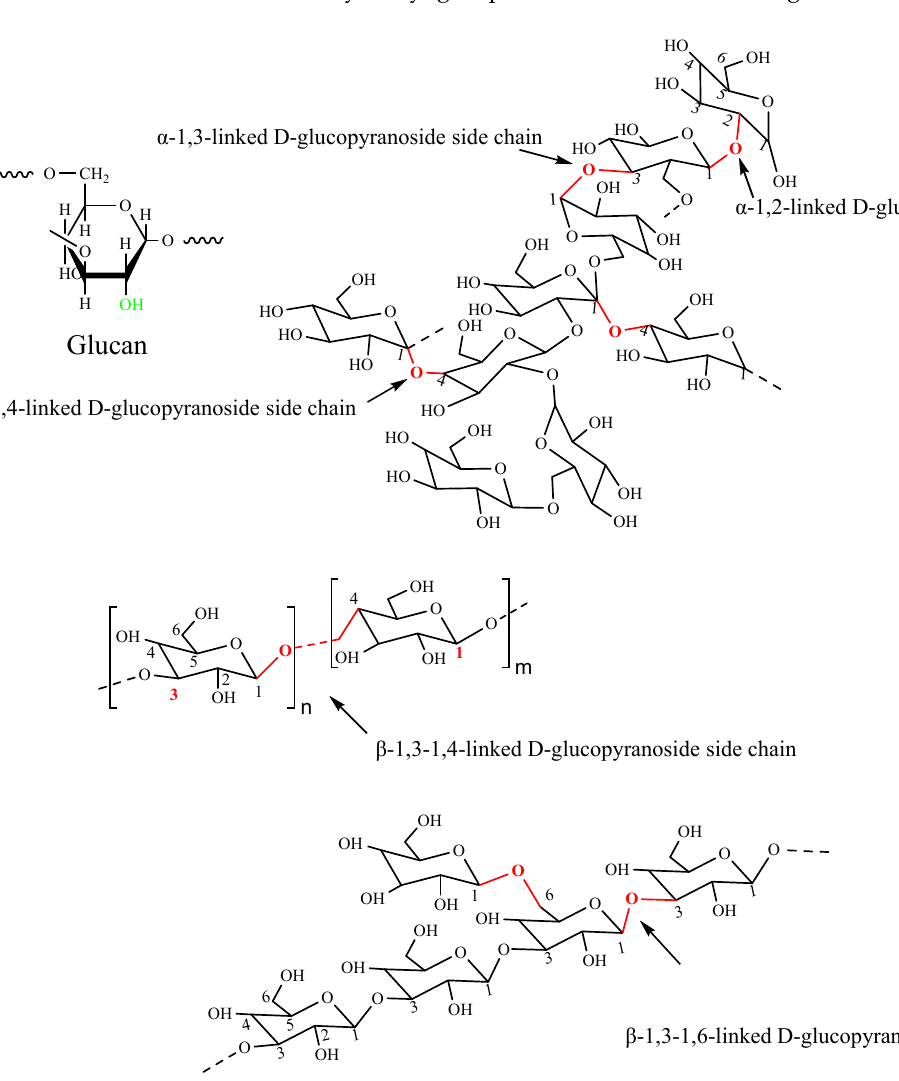
Figure 3. The structures of α -D-glucan and β -D-glucan.